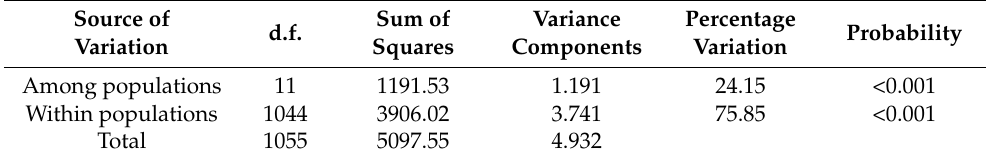
Table 3. Analysis of molecular variance (AMOVA) within and among